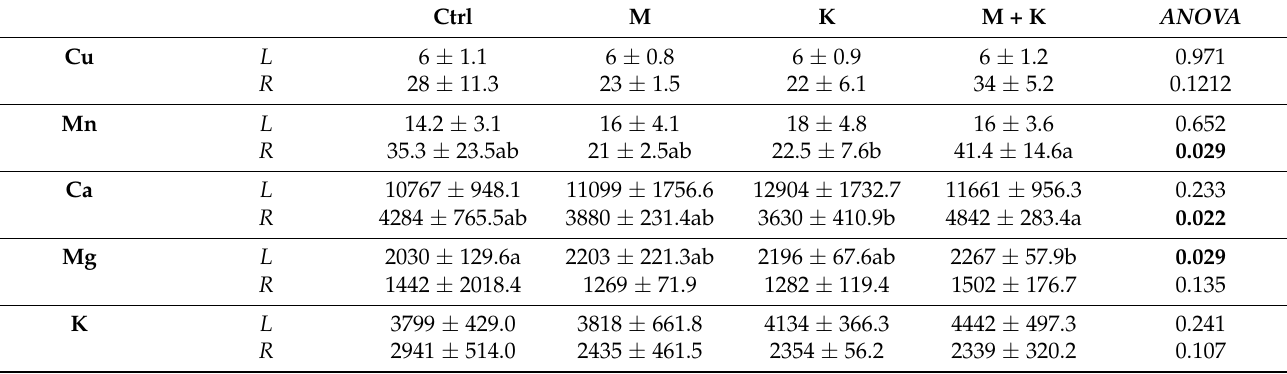
Table 4. Micro- (Cu, Mn) and macronutrient (Ca, Mg, K) concentrations (mg kg − 1 DW) in leaves (L) and roots (R) of cuttings of the Populus cultivar ‘Marke’ after 6 weeks of growth on trace elements polluted soil. Ctrl (control): non-inoculated cuttings; M: Methylobacterium sp. CP3 inoculation; K: Kineococcus endophyticus CP19 inoculation; M+K: Methylobacterium sp. CP3 and Kineococcus endophyticus CP19 inoculation. Statistical significance was determined with one-way ANOVA followed by Tukey’s Multiple Comparison Test ( p ≤